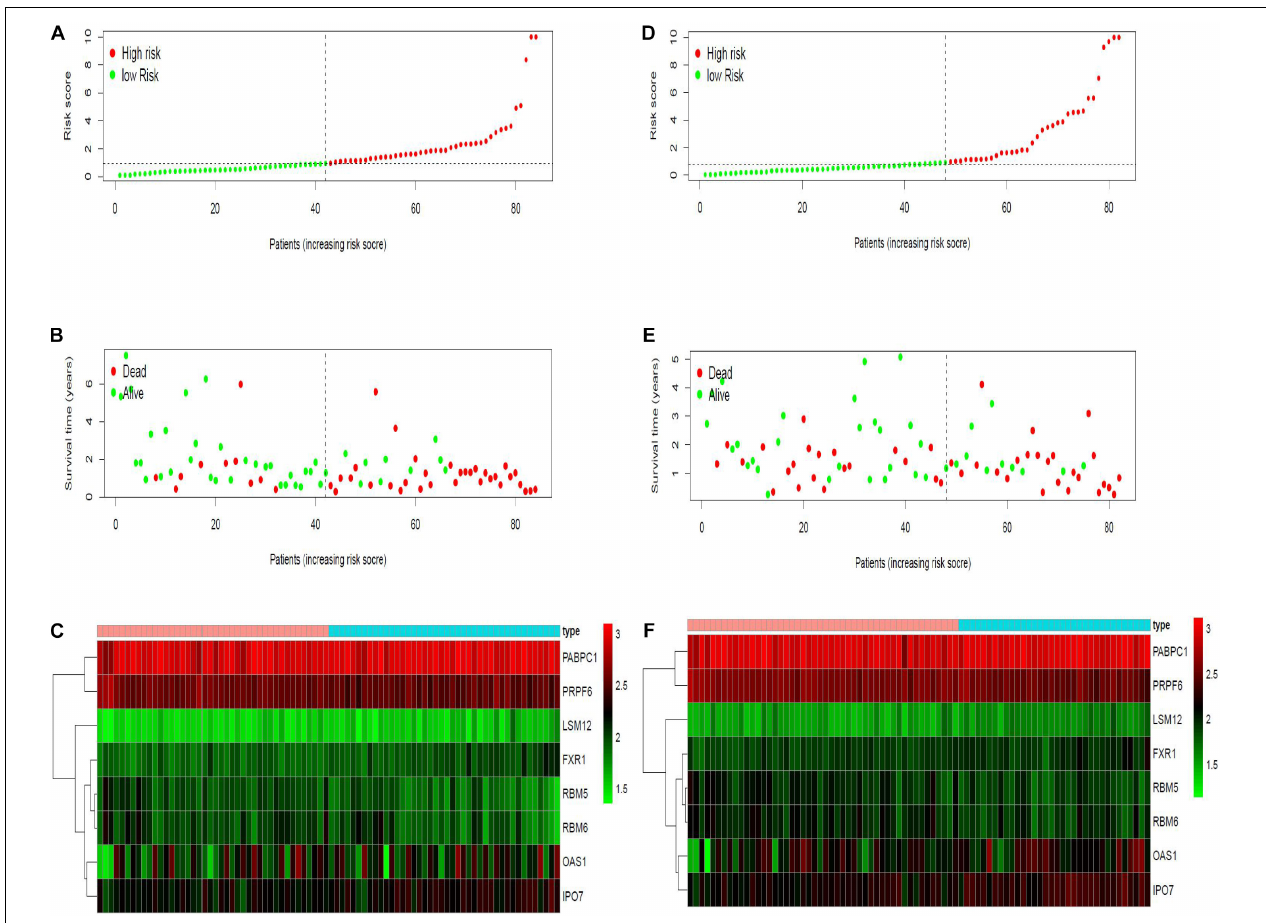
FIGURE 7 | Risk curves in modeling and validation cohort. X - axes of the six figures all represent PAAD samples, arranged in order of increasing risk score. (A,D) Dot plot of risk score. Y -axis represents risk score. Red and green color dots represent, respectively, high- and low-risk score samples. (B,E) Dot plot of survival. Y -axis represents survival times (years). Red and green color dots represent, respectively, dead and living PAAD samples. (C,F) Heat map. Y -axis represents eight modeling RBPs. Higher, medium, and lower expression levels of RBPs are shown in red, black, and green, respectively. Blue and pink bars on top of the heat map indicate low- and high-risk score samples,